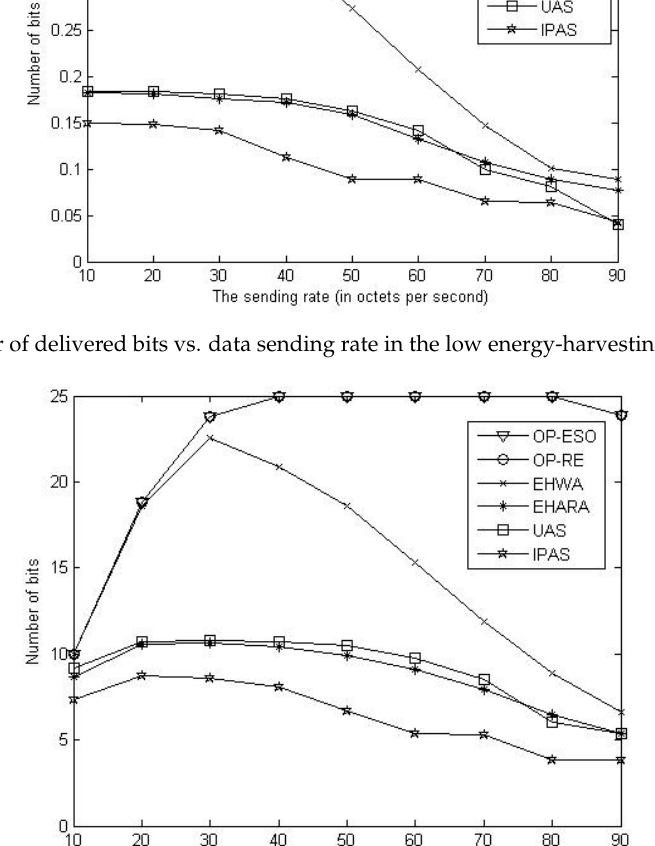
Figure 6. Number of delivered bits vs. data sending rate in medium energy-harvesting rate (MER) case. Sensors 2019 , 19 , x FOR PEER REVIEW